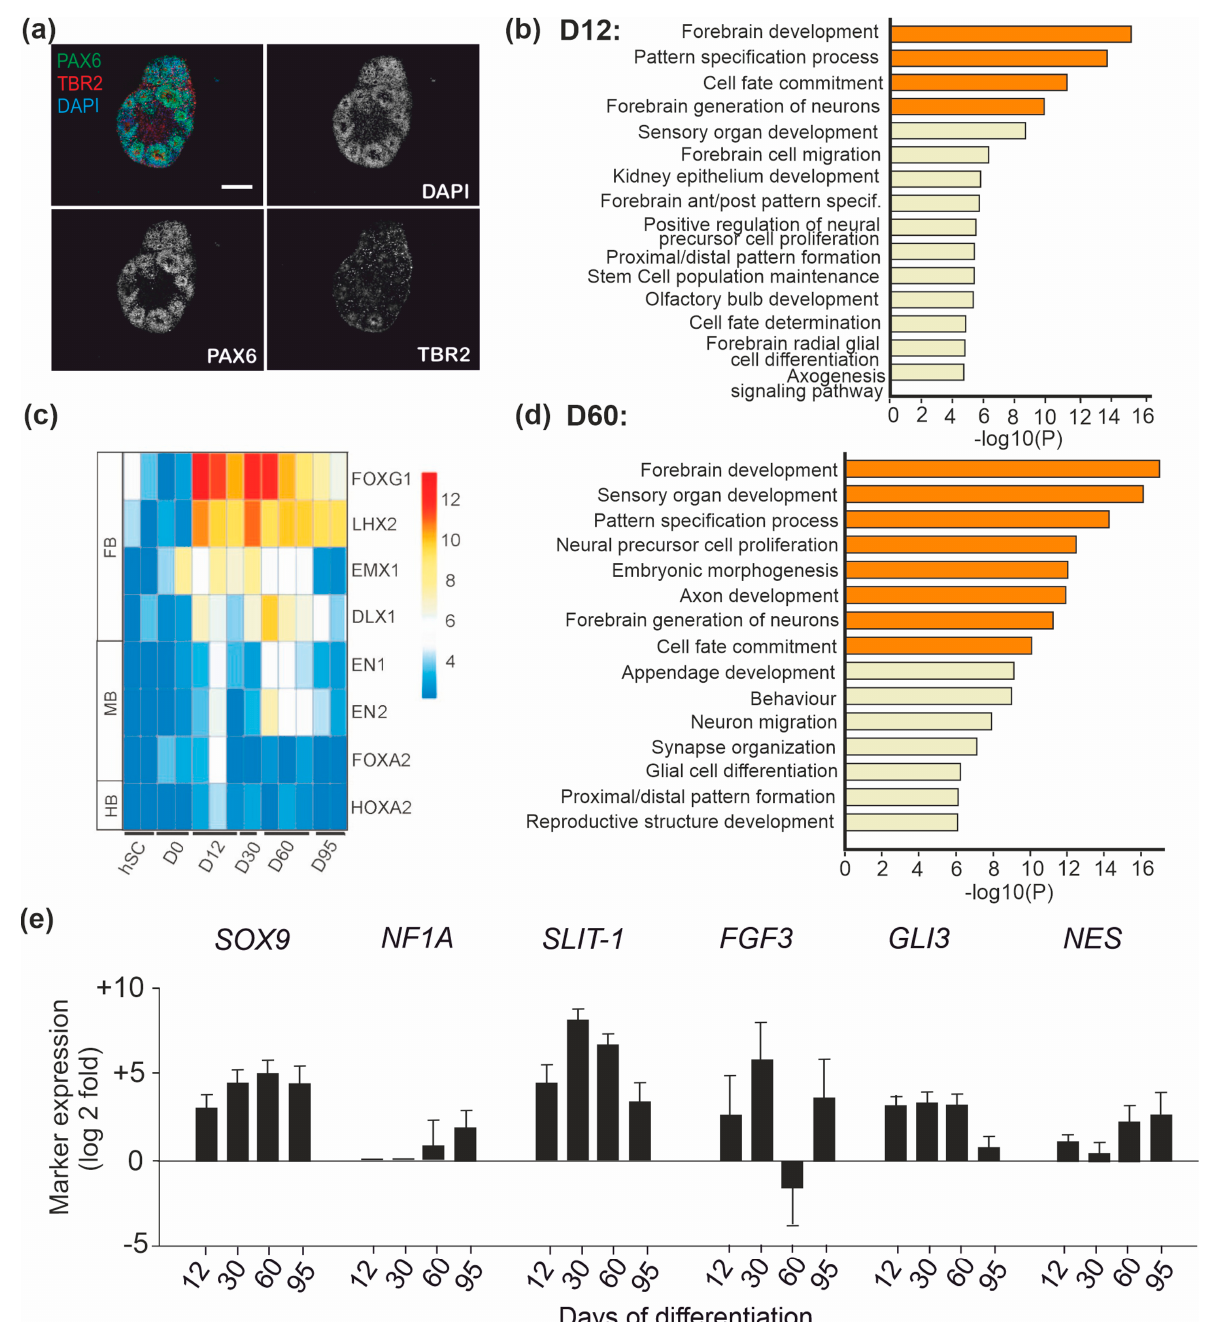
Figure 2. Patterning and fate determination of progenitors. ( a ) Progenitor differentiation was induced to neural lineages with dual SMAD inhibition and patterned towards forebrain identity. Representative images showing immunocytochemistry for PAX6 and TBR2 in neurospheres at D30 in vitro. ( b ) Ontology clusters of enriched transcripts (log2-fold, p < 0.05, p adjust < 0.1) in RNA-seq data at D12. ( c ) Heatmap showing expression of representative forebrain (FB), midbrain (MB), and hindbrain (HB) markers in RNA-seq analysis of undifferentiated hPSCs and during astrocyte differentiation at D12, D30, D60, and D95. ( d ) Ontology clusters of enriched transcripts (log2-fold, p < 0.05, p adjust < 0.1) in RNA-seq data at D60. ( e ) Expression of transcript encoding factors implicated in astrocyte fate determination and/or differentiation ( SOX9 , NF1A , SLIT-1 , FGF3 , GLI3 , and NES ) at D12, D30, D60, and D95 relative to the expression at D0 levels during astrocyte differentiation. Error bars represent